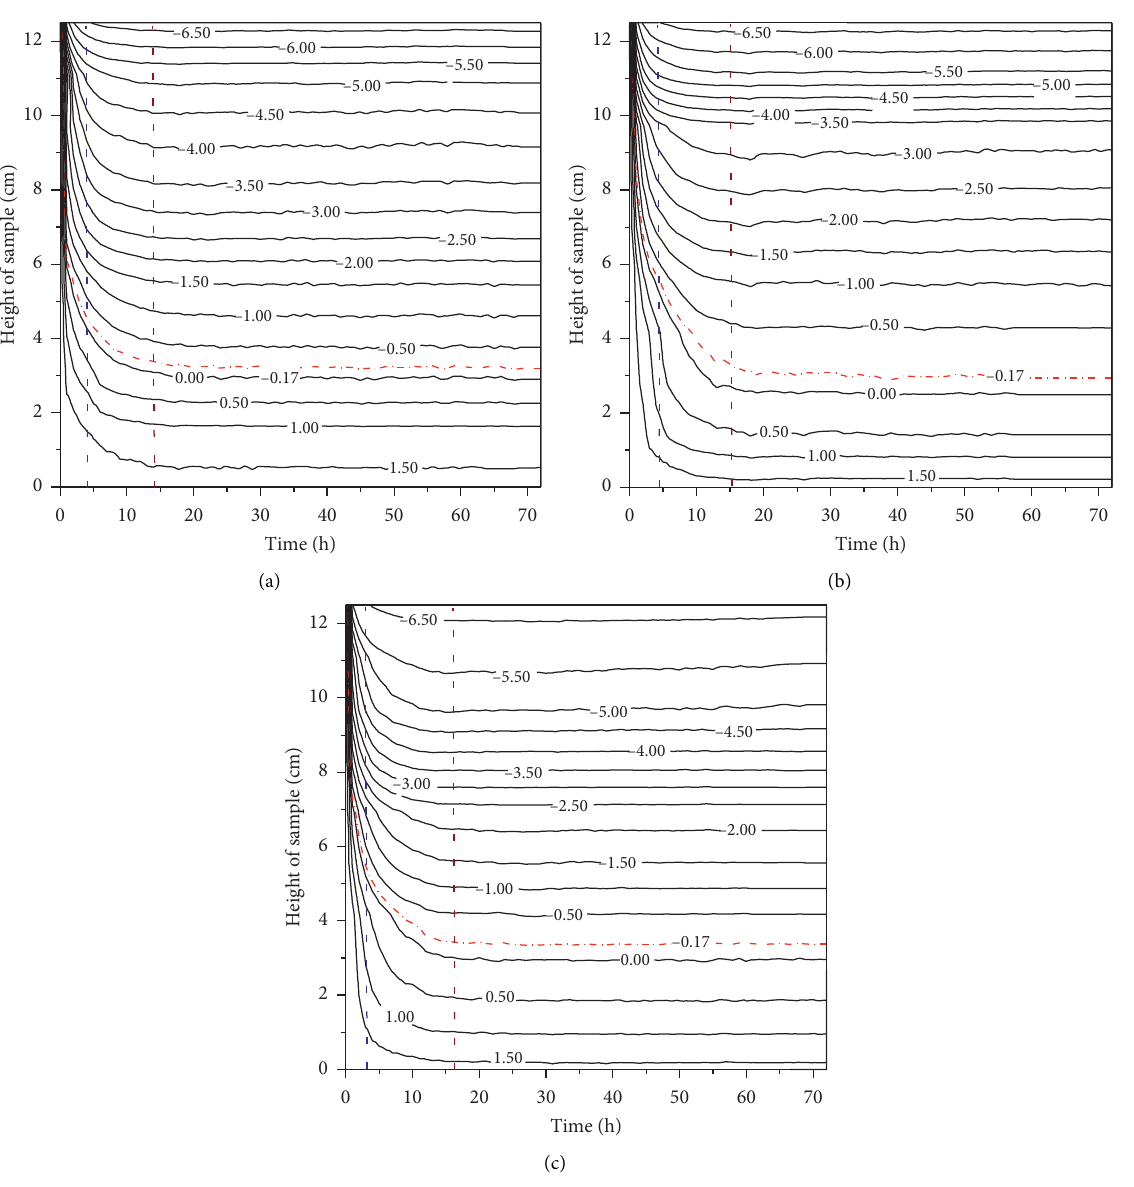
Figure 4: The temperature changes in soil samples with different dry densities. (a) ρ g ∙ cm − 3 , T top �− 7 ° C, and ω � 17%; (c) ρ d � 1.75 g ∙ cm − 3 , T top � − 7 ° C, and ω �